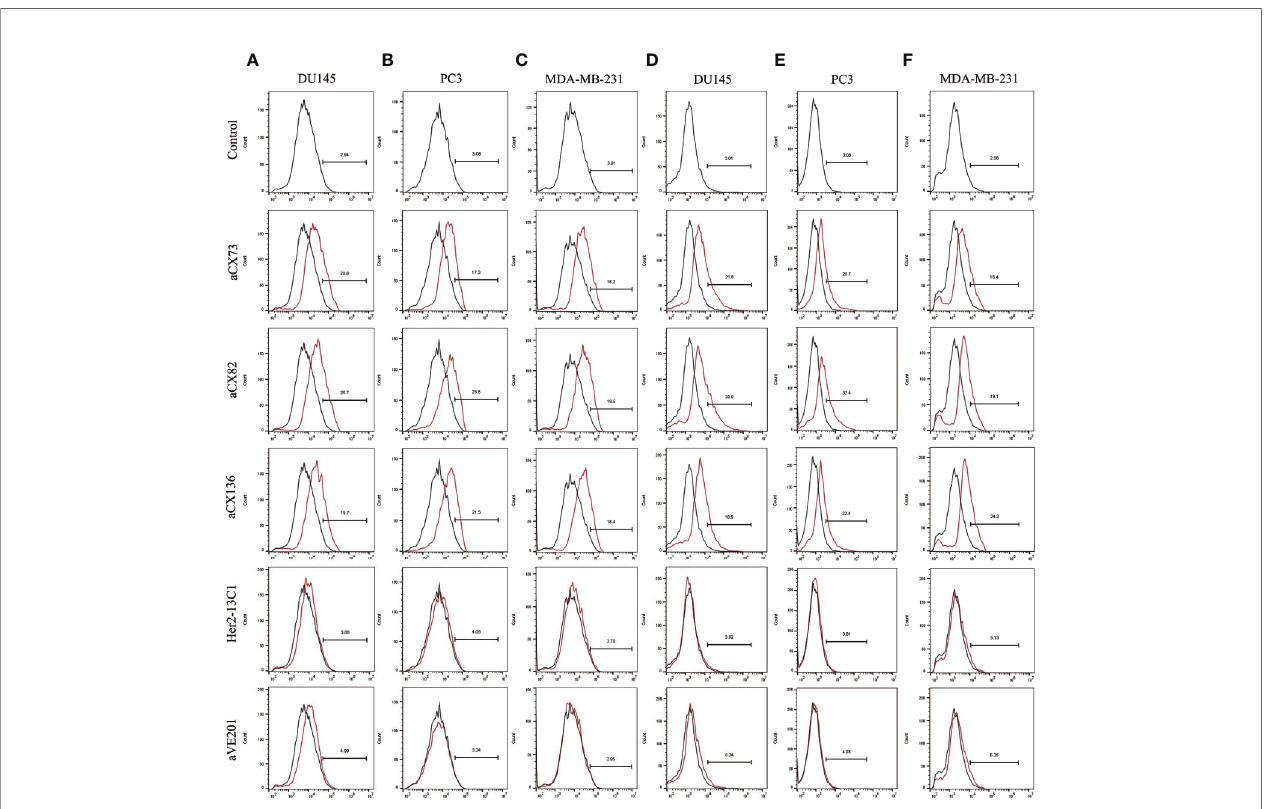
FIGURE 6 | Expression of the apoptosis-related proteins c-caspase-3 and c-PARP-1 was also detected by fl ow cytometry. C-caspase-3 expression was examined after DU145 (A) , PC3 (B) , and MDA-MB-231 (C) were treated for 48 h with the three anti-CXCR4 scFvs (aCX73, aCX82 and aCX136). C-PARP-1 expression was also tested in DU145 (D) , PC3 (E) , and MDA-MB-231 (F) . The PBS control and the two negative control antibodies (Her2-13C1 and aVE201) were also